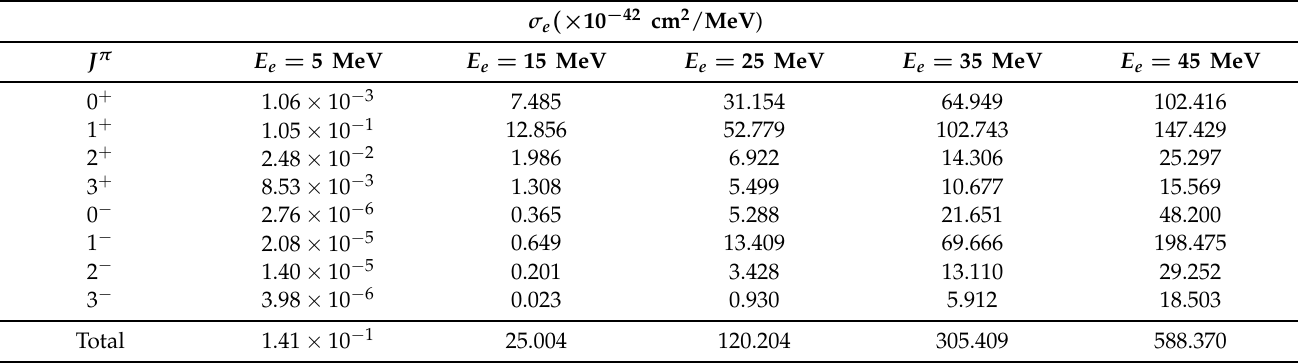
Table 3. Partial e − -capture cross-sections (in 10 − 42 MeV − 1 cm 2 ) on the 66 Zn isotope for different values of incident electron energy E e .